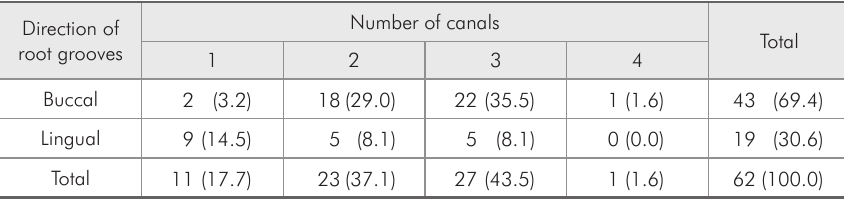
Table 3 - Correlation between number of canals and direction of root grooves [n ( % )].